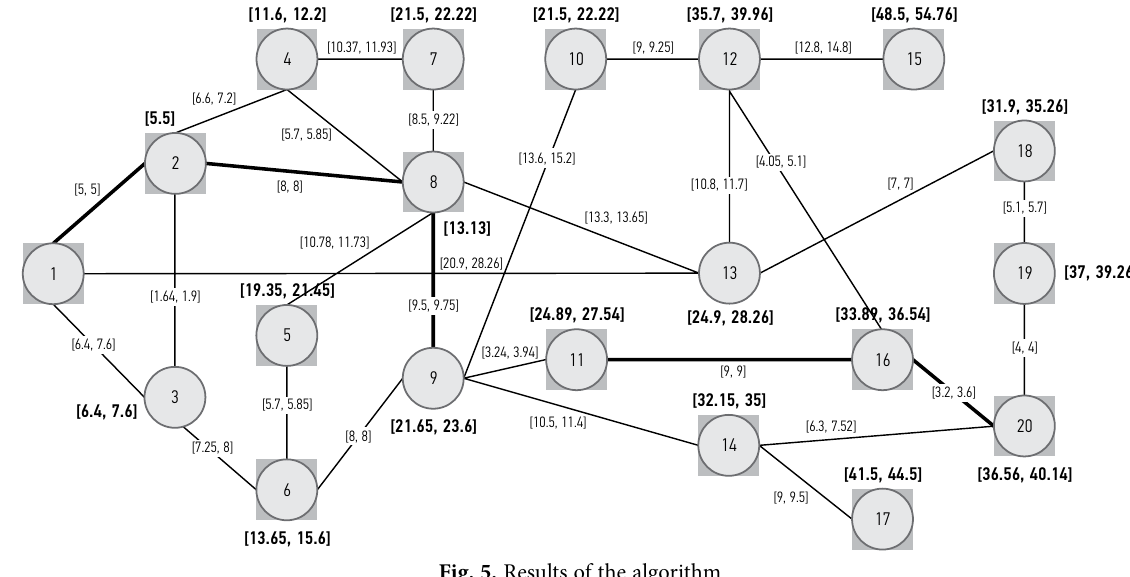
Fig. 5. Results of the